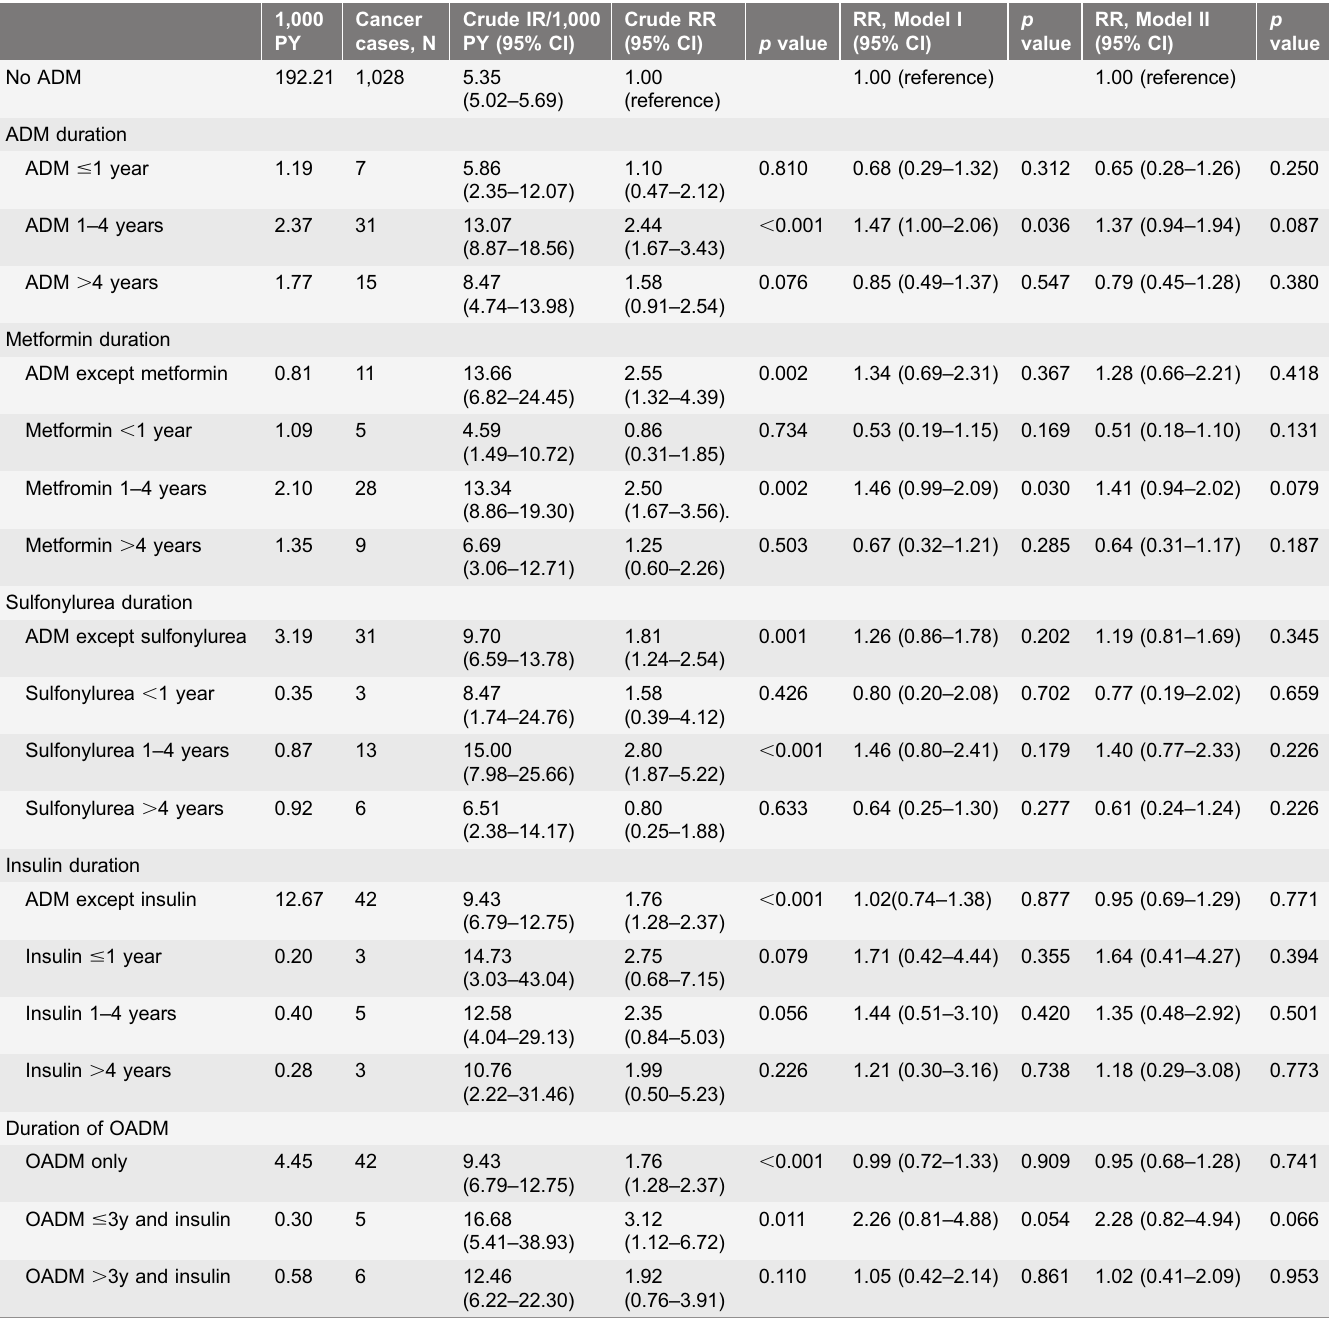
Table 3. Variation in the cancer risk ratio in relation to exposure duration for users of ADM compared to